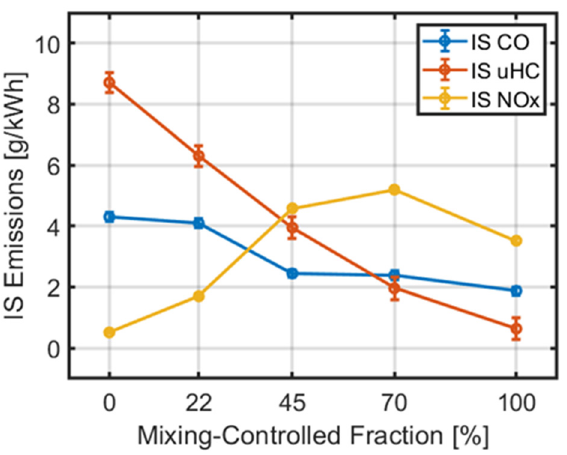
Figure 12. Indicated specific emissions of CO (IS CO), IS uHC, and IS NOx vs. mixing-controlled fraction.